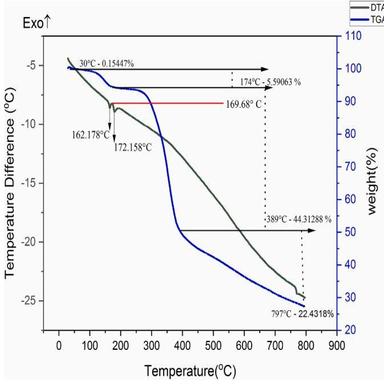
TG/DTA THERMOGRAM